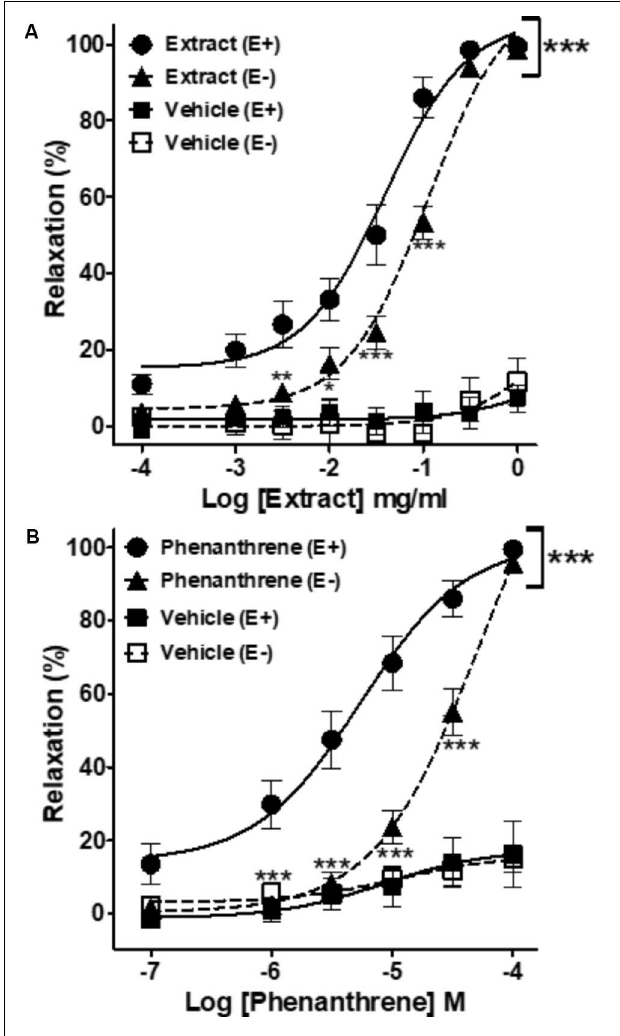
FIGURE 1 | Cumulative concentration-response curves of the Eulophia macrobulbon (EM) extract and vehicle (DMSO 0.23%) (A) or of 1-(4 (cid:48) -hydroxybenzyl)-4,8-dimethoxyphenanthrene-2,7-diol (phenanthrene) and its vehicle (DMSO 0.18%) (B) in endothelium-intact (E+) and -denuded (E–) mesenteric rings. Relaxations are expressed as % contractions induced by 10 − 5 M PE. Values are means ± SEM of n individual arteries. ∗ p < 0.05, ∗∗ p < 0.01, ∗∗∗ p < 0.001 vs. Extract (E+) or phenanthrene (E+) ( n =